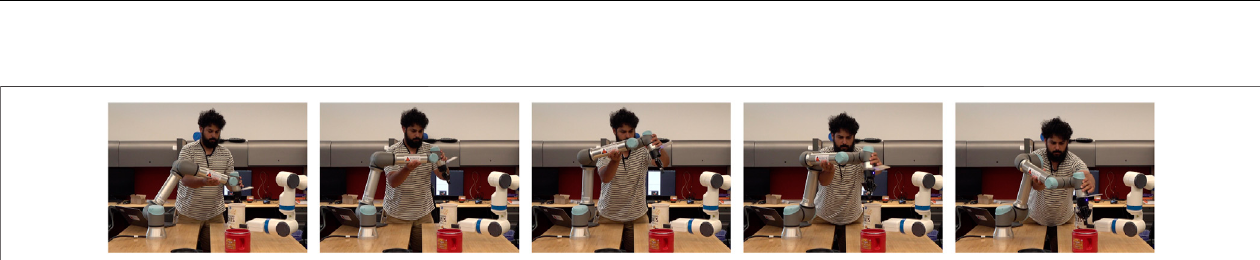
Frontiers in Robotics and AI |